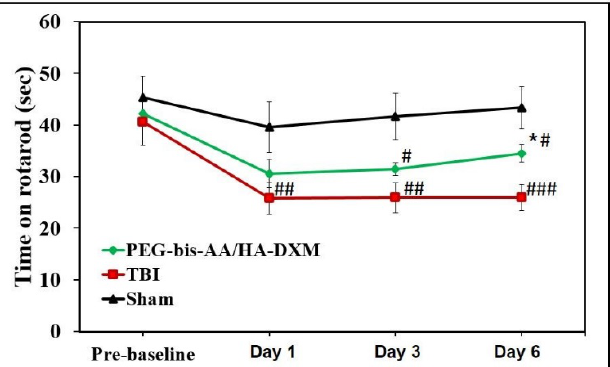
Figure 1. Effect of PEG-bis-AA/HA-DXM hydrogels on motor function by rotarod test. ( n = 9 rats PEG-bis-AA/HA-DXM, n = 8 rats untreated TBI, n = 8 rats sham; data presented as mean ± STD; ONE-WAY ANOVA, post hoc: Tukey HSD; # p < 0.05, ## p < 0.01, ### p < 0.001 compared to sham; * p < 0.05 compared to TBI).